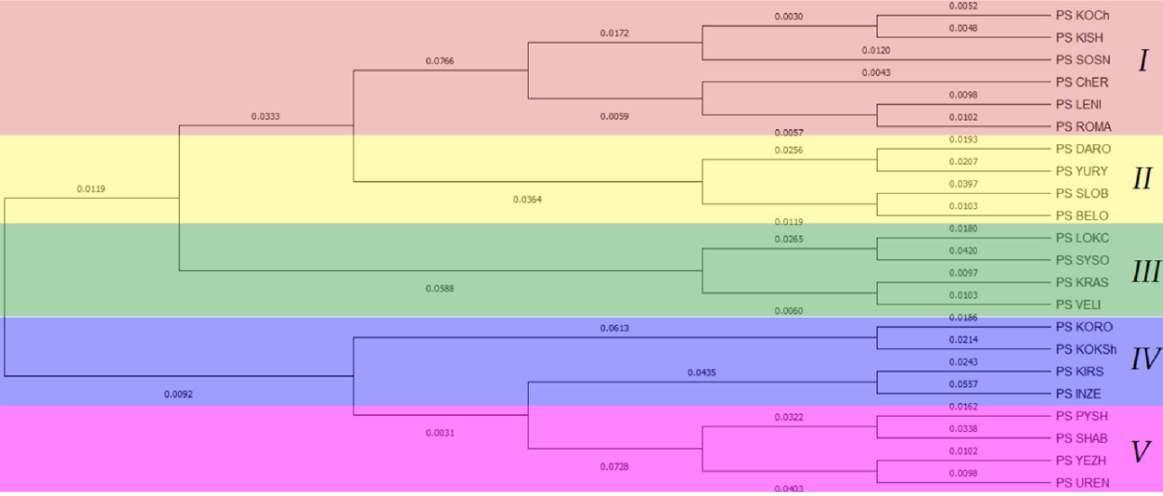
Figure 2. Dendrogram of genetic similarity of twenty-two studied populations of P. sylvestris , built based on polymorphism of ISSR profiles by Neighbor-joining method.